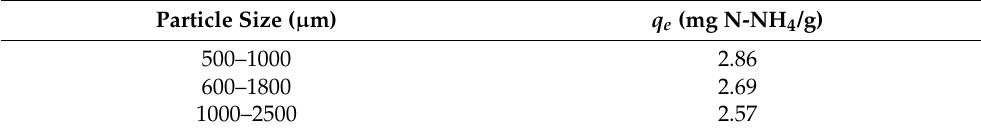
Table 3. Adsorption capacity of natural zeolite when C o = 30 mg N-NH 4